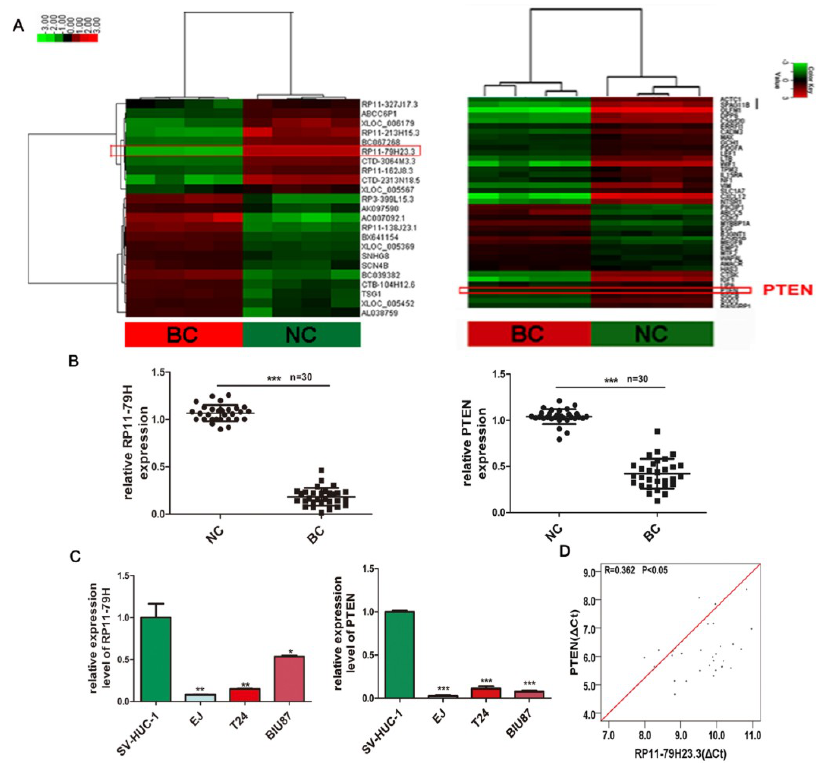
Figure 1. The expression of RP11-79H23.3 and phosphatase and tensin homolog (PTEN) in bladder cancer (BC) tissues and cells and the relationship between them. ( A ) Heat maps showed that the profiles of differentially expressed long noncoding RNAs (lncRNAs) ( left ) and mRNA ( right ) in bladder carcinoma tissues and adjacent noncarcinoma tissues ( n = 4) using microarray with fold change ≥ 2 and p -value < 0.05. Each row represents the expression level of a lncRNA/mRNA and each column represents an individual tissue sample. Red represents high expression levels and green represents low expression levels. ( B ) RP11-79H23.3 and PTEN expressions were evaluated by RT–qPCR in 30 cases of bladder cancer tissues and adjacent normal tissues. ( C ) The expressions of RP11-79H23.3/PTEN were measured in three BC cell lines and one normal bladder cell line. ( D ) A positive correlation between RP11-79H23.3 expression and PTEN level was determined by Pearson analysis in BC. Data is shown as mean ± SD (standard deviation). * p < 0.05; ** p < 0.01; *** p < 0.001.